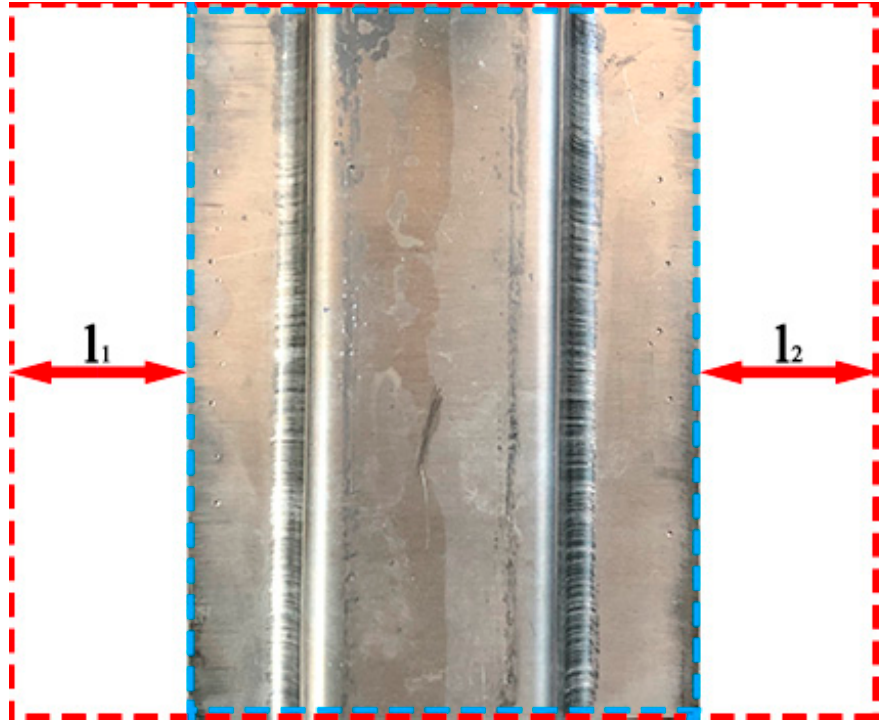
Figure 10. Measurement of material inflow after forming (red line is initial blank outline, blue line is the boundary outline formed part). l1, l2: material inflow.